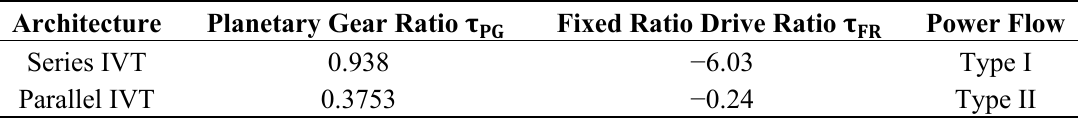
Table 3. Planetary gear (PG) and fixed ratio (FR) drives ratios of the IVT transmissions with power flows of Type I or